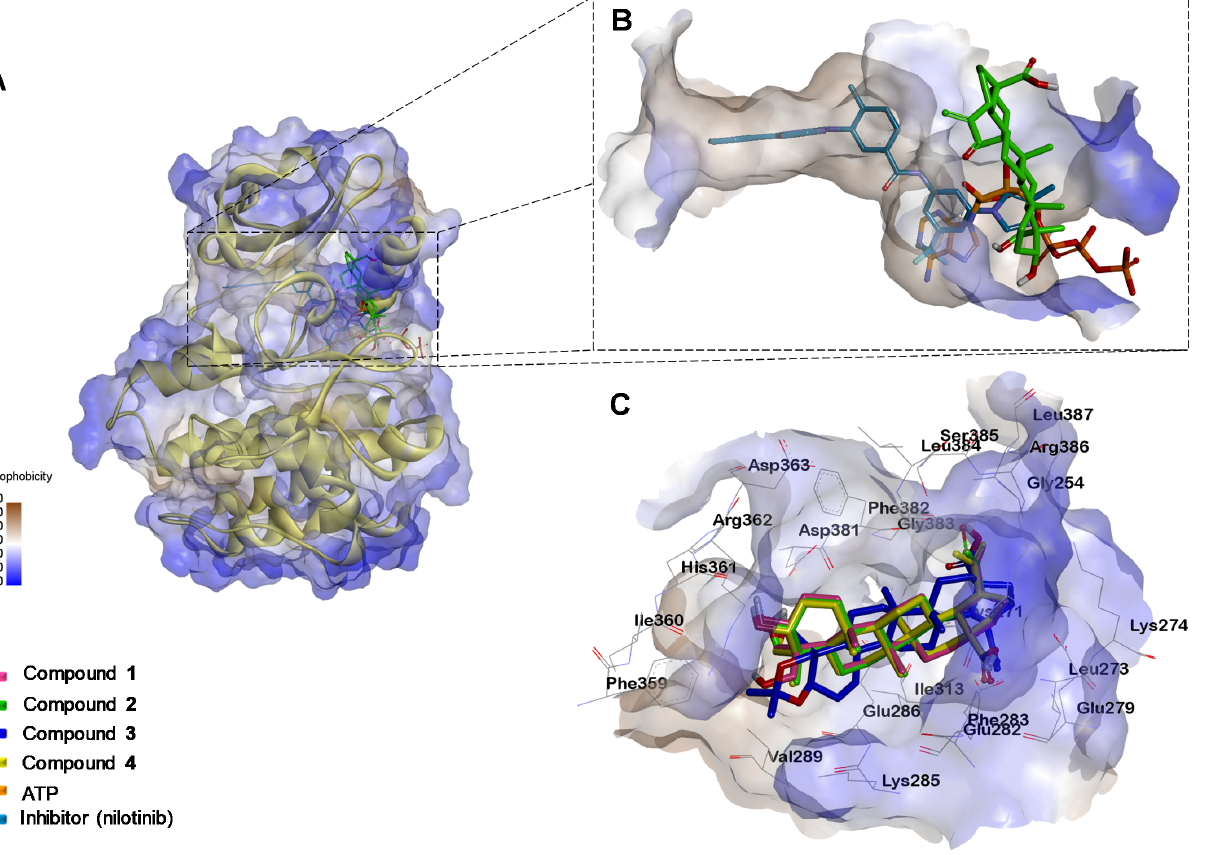
Figure 6. Binding modes of the compounds under study at the BCR-ABL binding site. ( A ) Binding site of nilotinib, ATP and compound 2 . ( B ) Close-up of the binding site of nilotinib (Re-docking RMSD: 0.717 Å), ATP and compound 2 . ( C ) Superimposition of compound 1 , 2 , 3 , and 4 into ATP binding site of ABL kinase.